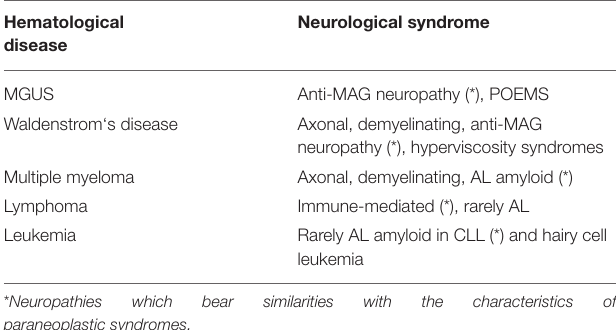
TABLE 5 | Neuropathies associated with hematological